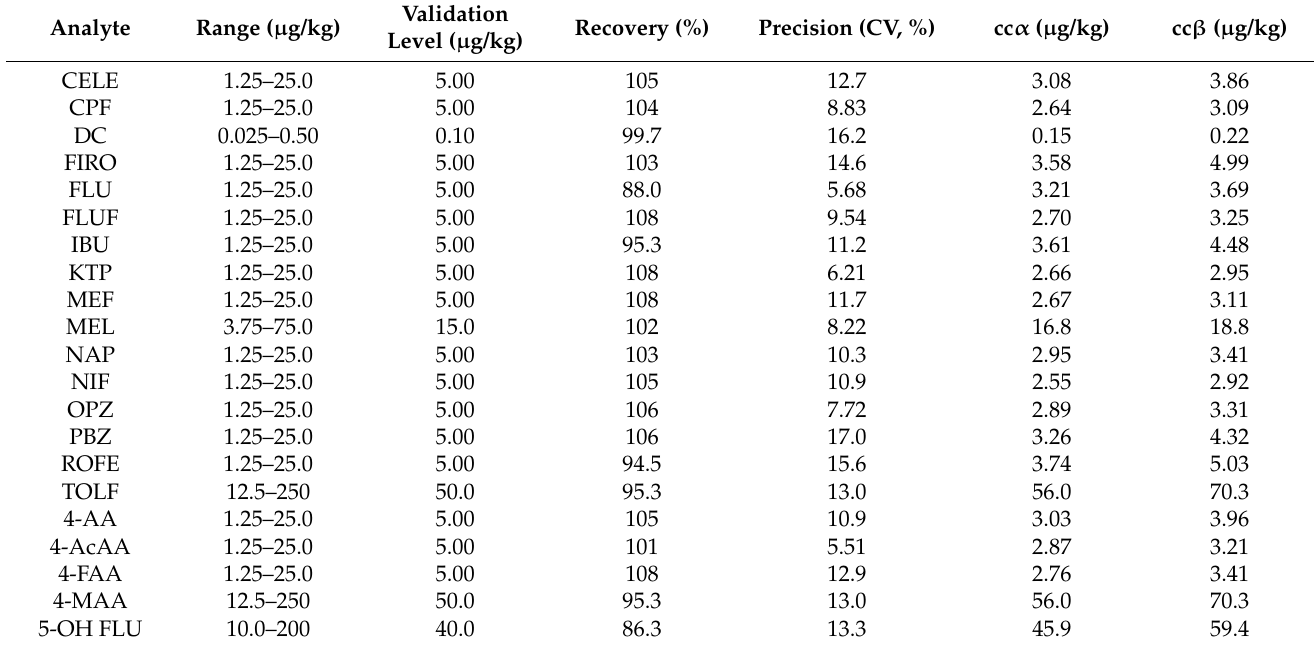
Table 2. Validation data for analyses of milk